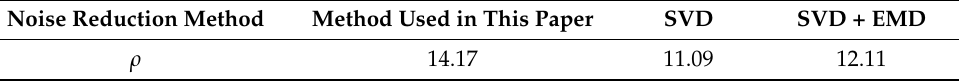
Table 4. Evaluation of denoising results of PD signals measured in the